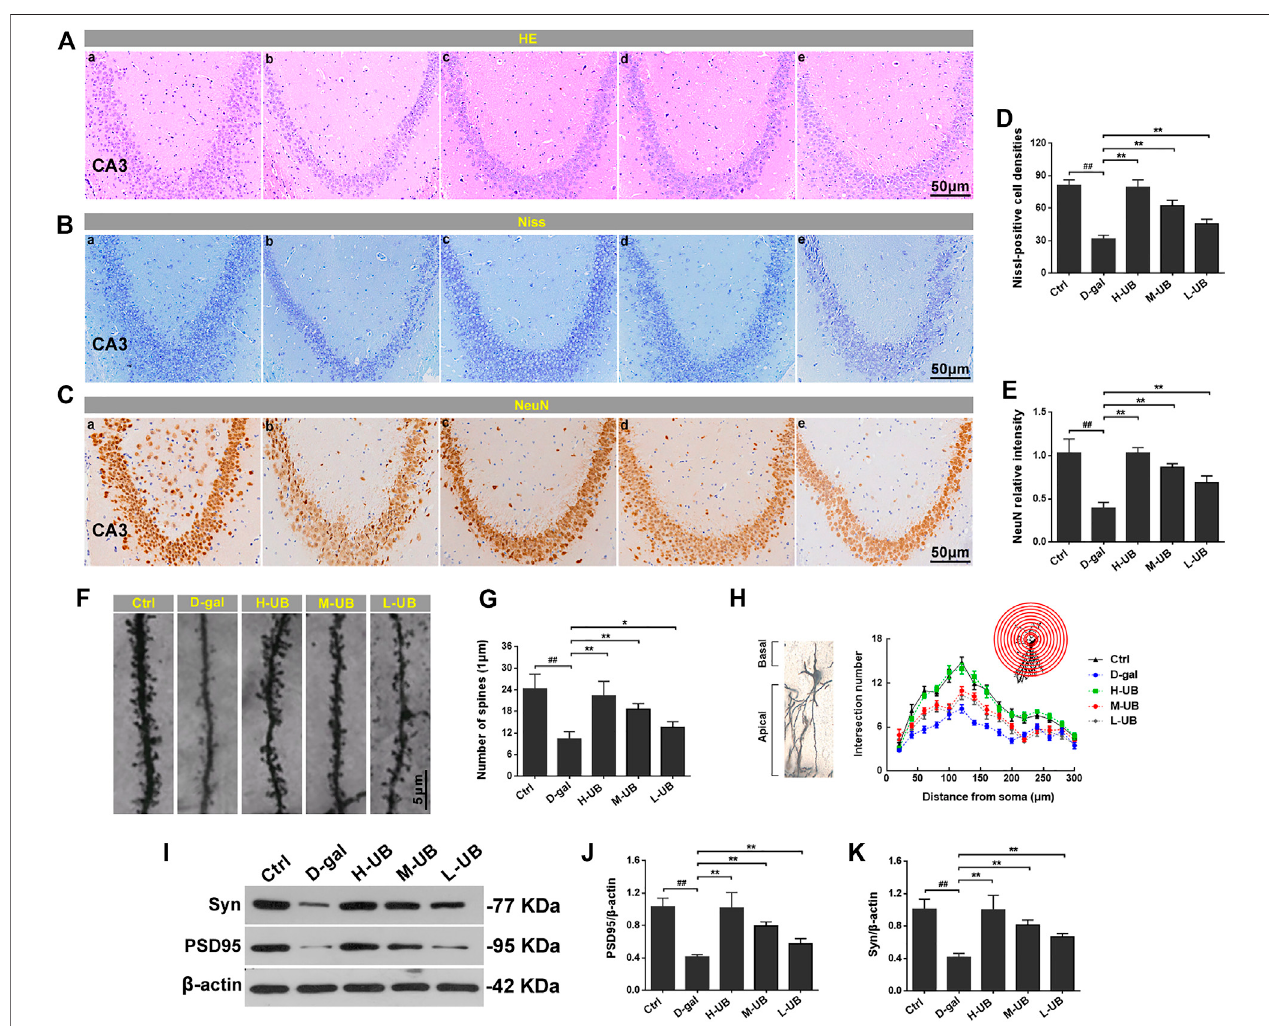
FIGURE 4 | Effect of UB on hippocampal pathology in D-gal-treated aging mice. Representative H&E (A) and Nissl (B) staining of hippocampal alterations. (C) Immunohistochemistry of NeuN in the hippocampus of each group. (D) The Nissl-positive cell densities for each group was counted at high magni fi cation ( n (cid:1) 6 per group). (E) The statistical analysis of NeuN relative intensity ( n (cid:1) 6 per group). Representative high magni fi cation images (F) and quanti fi cation of the spine number in agingmice (G) ( n (cid:1) 6pergroup). (H) Atleast10neuronspergroupwereanalyzed byShollanalysis. (I) Theexpression ofSynand PSD95wasdetected bywestern blotting.Quanti fi cation analysisofPSD95 (J) and Syn (K) .Datawerenormalizedto β -actinproteinexpression ( n (cid:1) 6per group).Allresultsaredescribed asmeans ± SD. # p < 0.05 and ## p < 0.01 vs the control group; * p < 0.05 and ** p < 0.01 vs the D-gal-induced aging group.